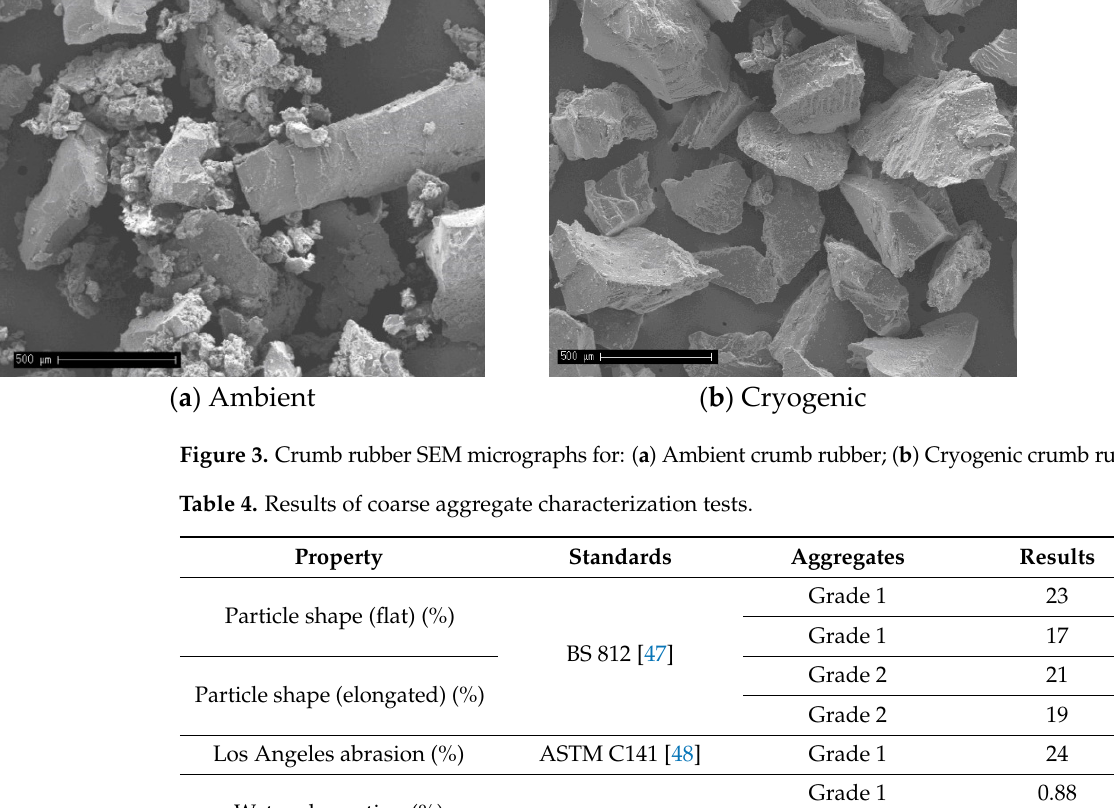
Table 4. Results of coarse aggregate characterization tests.